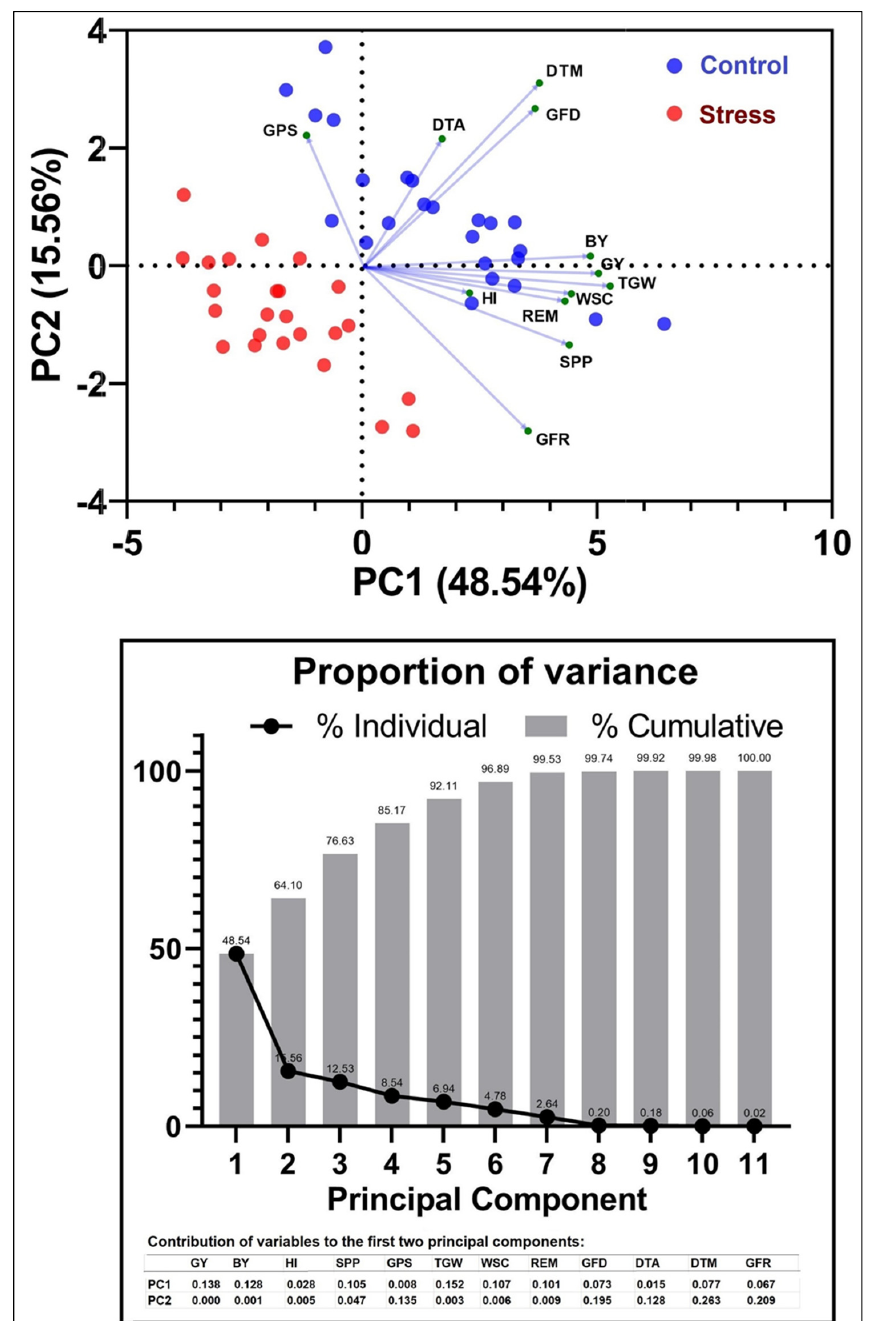
Figure 8. Principle Component Analysis (PCA) Biplot (top) of different traits (arrows) and wheat cultivars (points). Cultivars are dispersed in different ordinates based on the dissimilarity among them. The magnitude of the vectors (lines) shows the strength of their contribution to each PC. The angles between the vectors derived from the middle point of biplots exhibit positive or negative interactions of studied traits. The close variables (vectors) forming small angles represent a highly positive correlation among them. The PCA scree plot (bottom) shows the proportion of variance of different principal components. (GY—grain yield (g pot − 1 ); BY—biomass yield (cm seedling − 1 ); HI—harvest index (%); GPS—grain per spike (no); TGW—thousand-grain weight (g); WSC—Water-soluble carbohydrates in culm at milk ripe stage (mg g − 1 DW); REM—Amount of remobilized WSCs (mg mg − 1 Culm DW); GFD—grain filling duration (d); DTA—days to anthesis (d); DTM—days to maturity (d); GFR—grain filling rate (mg grain − 1 d − 1 ); SPP—spike per pot).